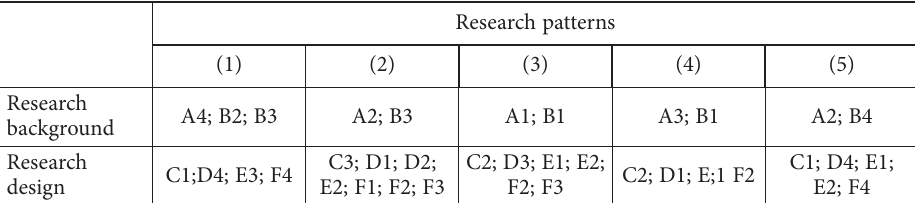
Table 5. Assigning analytical framework‘s attributes into research